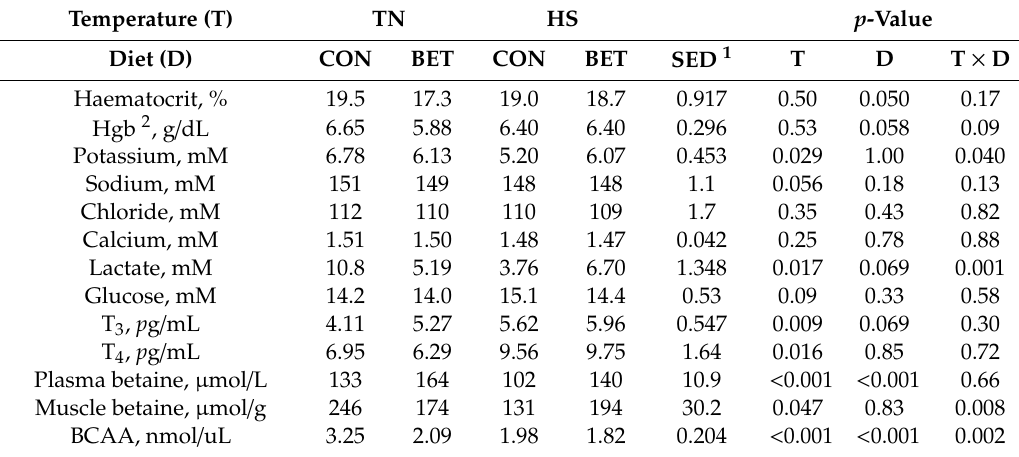
Table 3. E ff ect of betaine (BET) on haematology, electrolytes, metabolites, plasma thyroid hormones, betaine distribution and branched chain amino acid during thermoneutral (TN) and heat stress (HS)